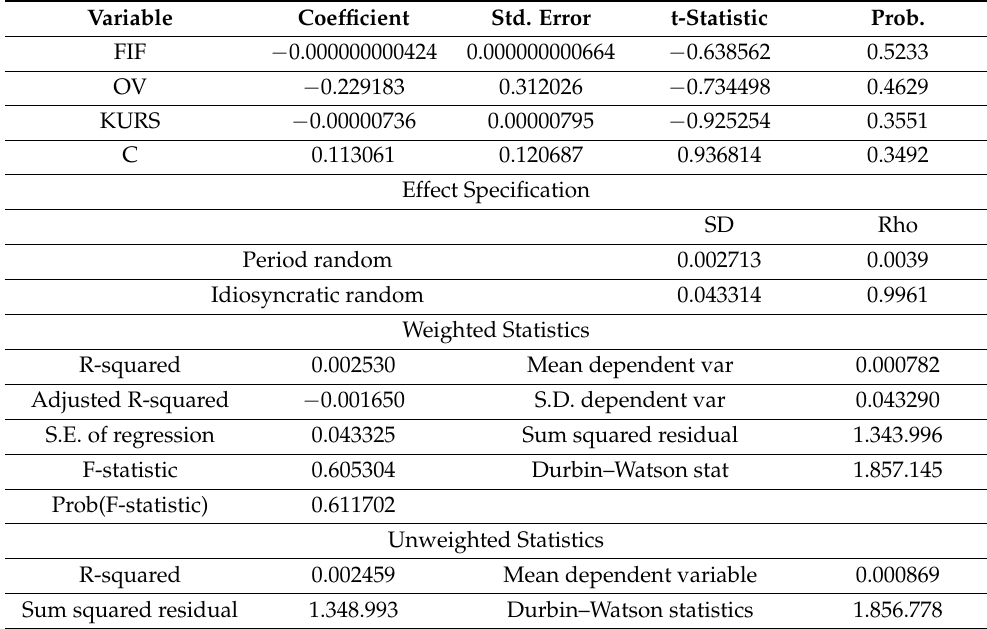
Table 20. Panel Data Regression After